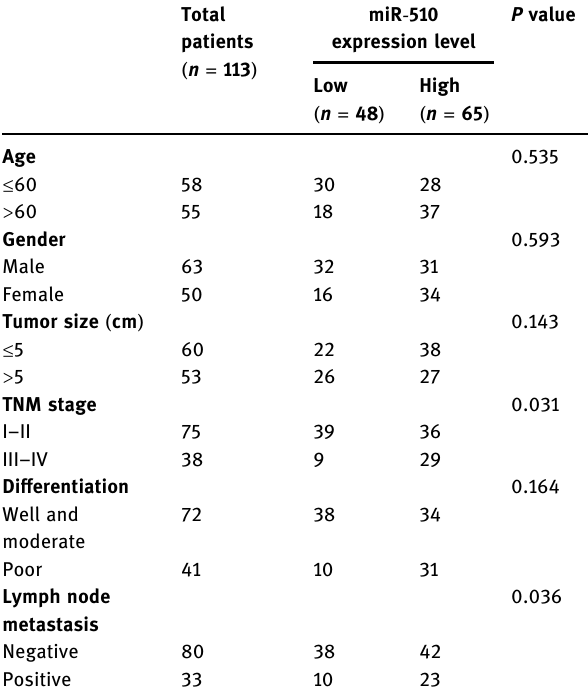
Table 1: Association between miR - 510 expression level and the clinical features of colon